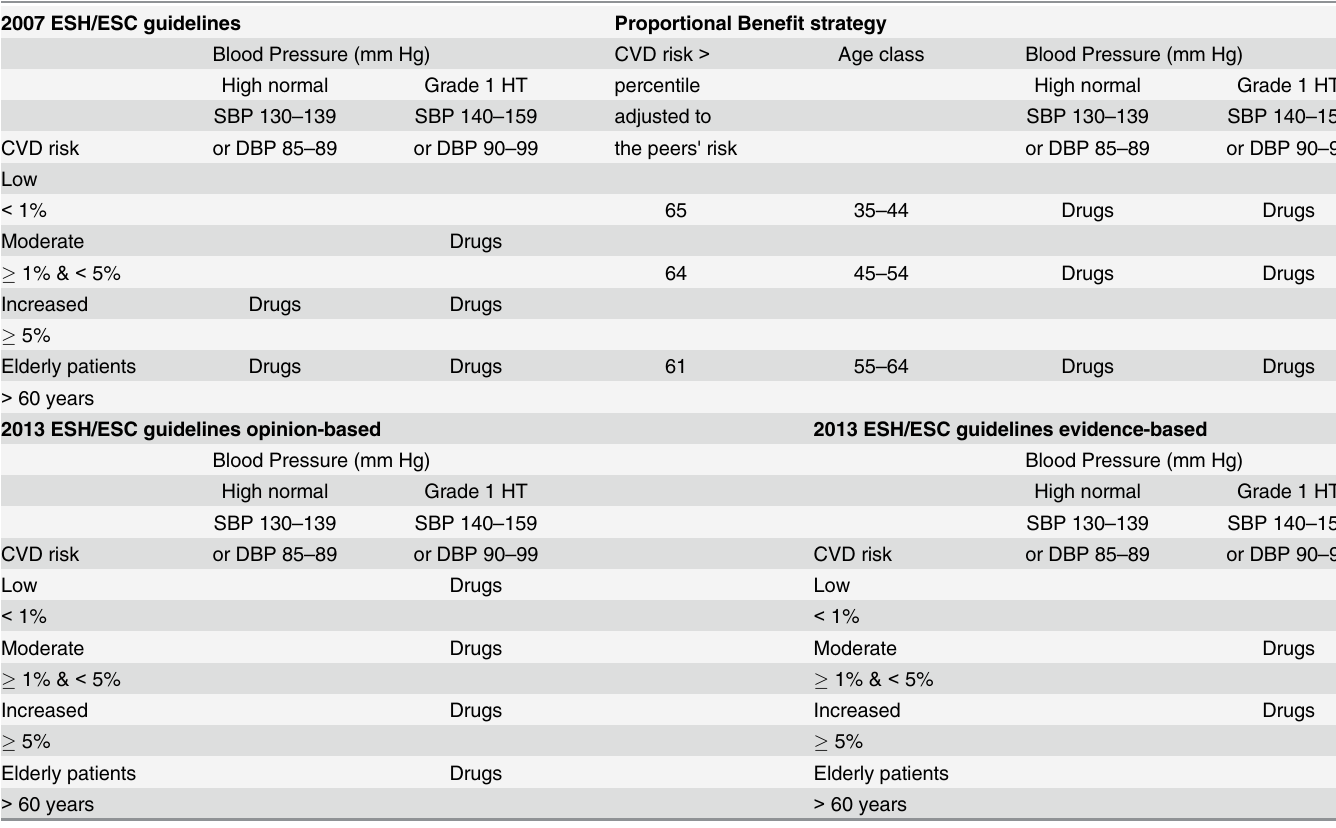
Table 1. Prescription scenarios according to ESH/ESC successive guidelines and the Proportional Benefit